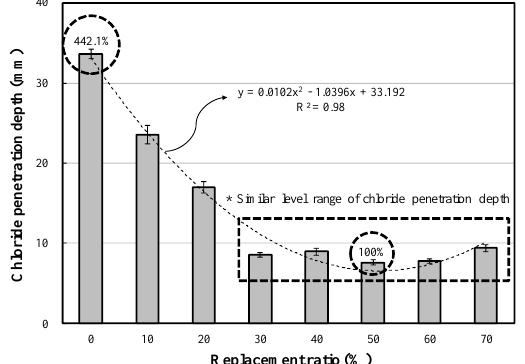
Figure 14. Chloride penetration depth relative to the replacement ratio.